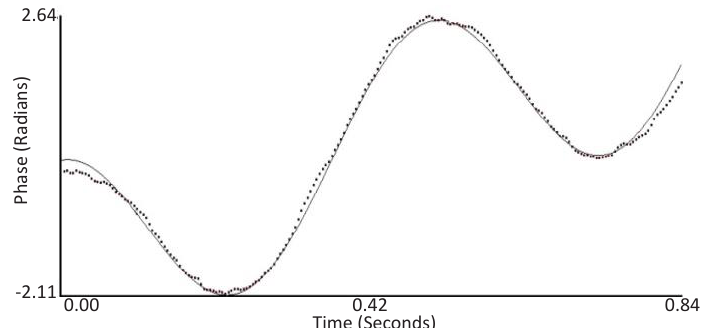
Fig. 3. Results of zeta potential measurement for gelatin nanoparticles